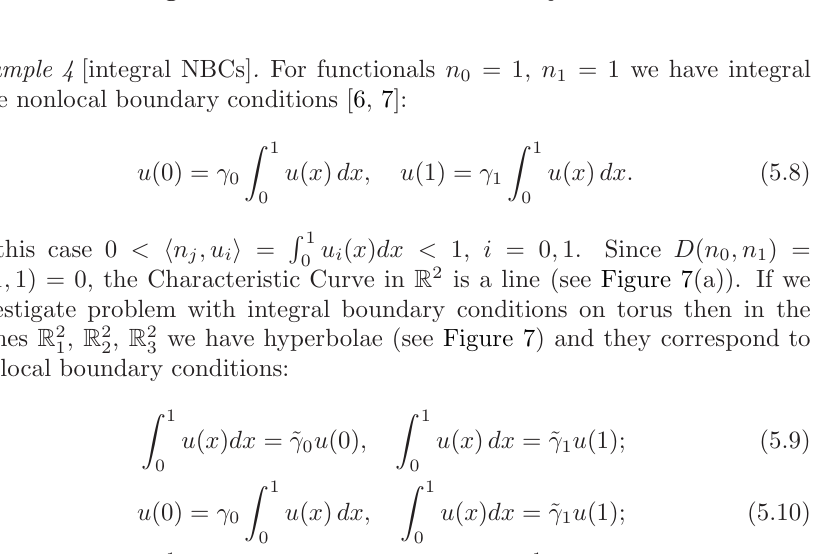
Figure 8. Characteristic Curve and area